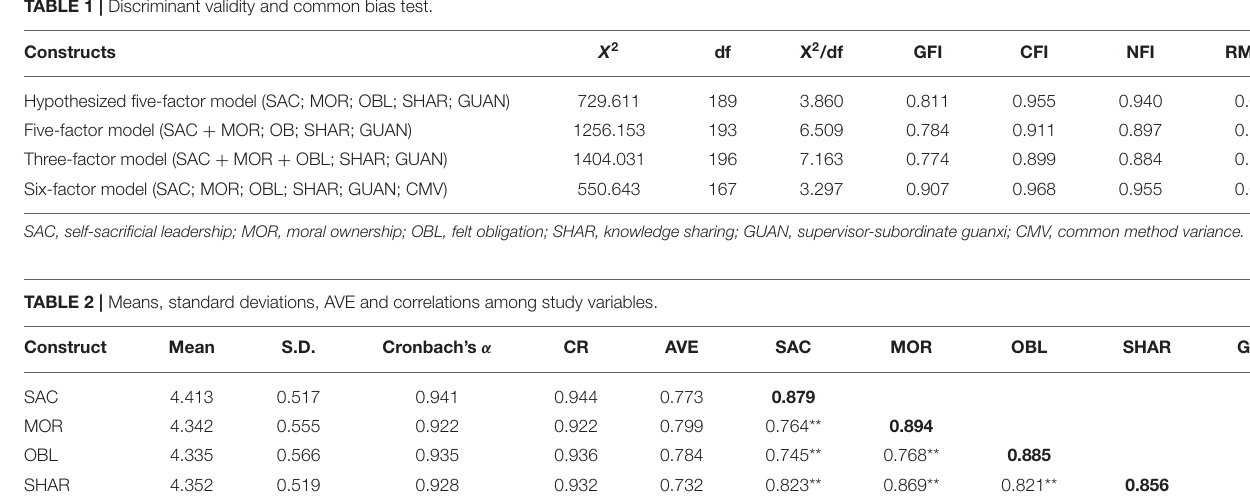
S.D.,standardizeddeviation;CR,compositionreliability;AVE,averagevarianceextracted.SAC,self-sacrificialleadership;MOR,moralownership;OBL,feltobligation;SHAR,knowledge